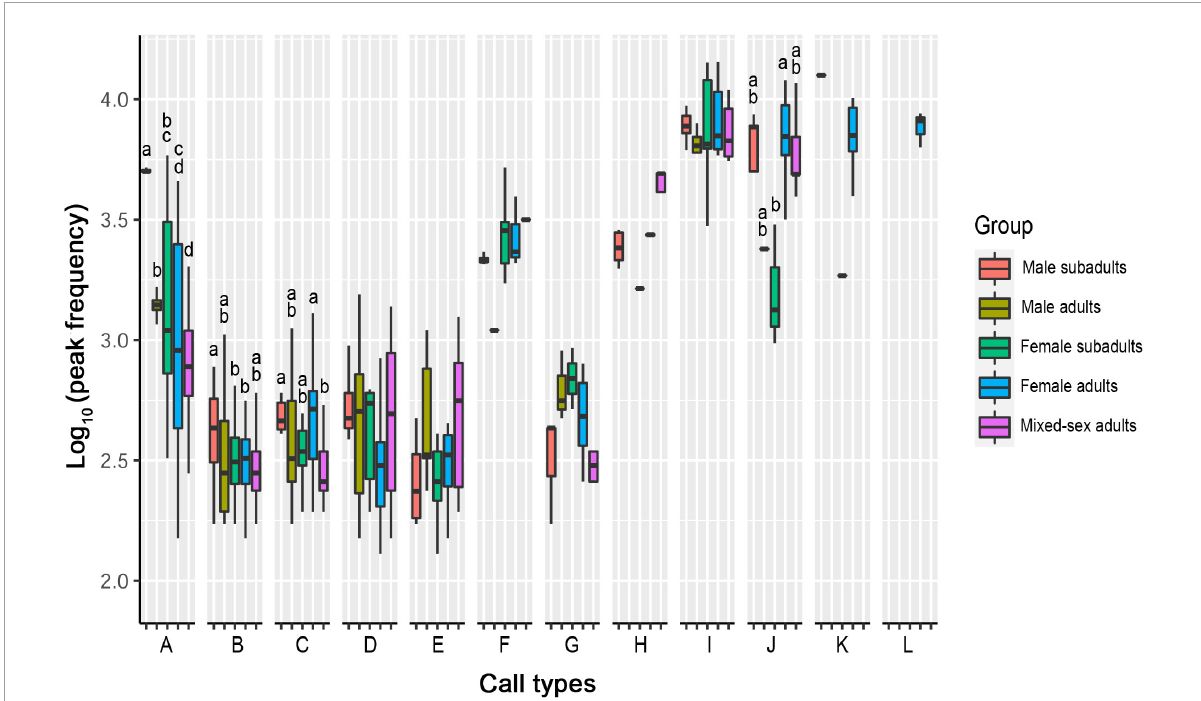
FIGURE3 Differences in peak frequencies among five sex–age groups for all call types. The y -axis is the log-transformed value of peak frequency. The x -axis represents the call types. Boxplots with different lowercase letters refer to Kruskal–Wallis comparison tests yielding significant results ( P < 0.05), and the relationship among the letters is a > b > c > d. Boxplots with the same lowercase letters did not significantly differ ( P > 0.05). Call types without letters on the boxplots showed no significant differences among sex–age